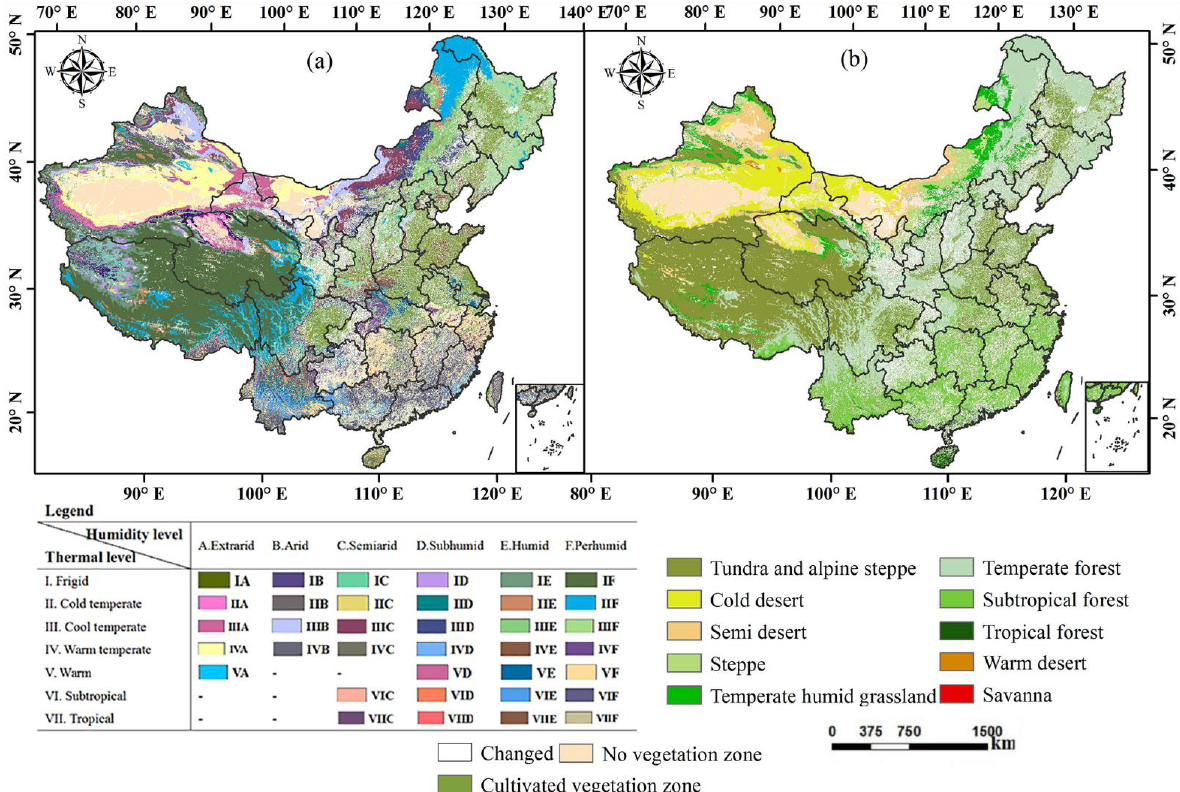
Figure 10. Spatial distribution of PNV ( a ) and PNV super-classes ( b ) in the baseline scenario.